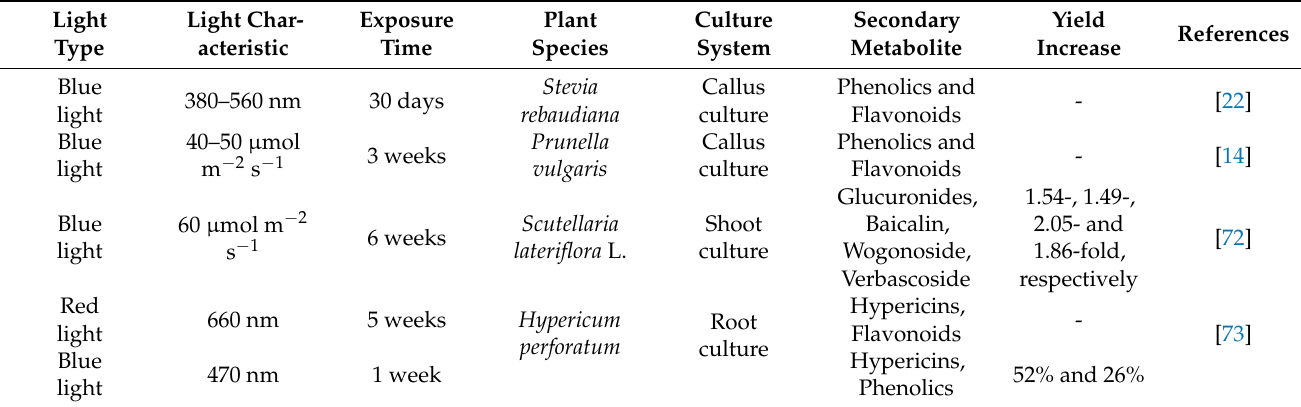
Table 2. Role of fluorescent light as an elicitor of key secondary metabolites in various in vitro systems of plants. Light